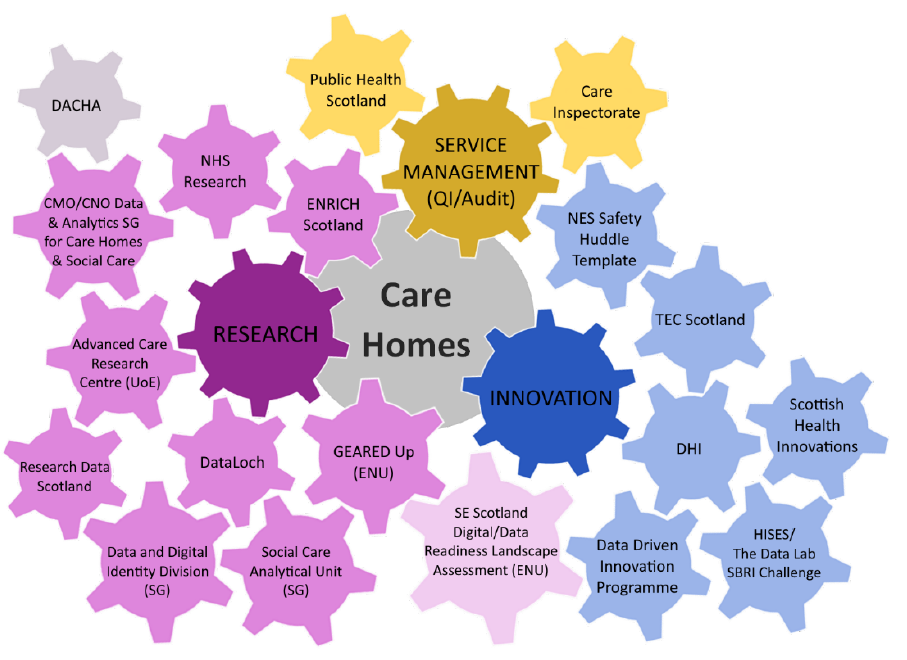
Figure 1. Multiple stakeholders are ‘gearing up’. A complex mix of stakeholders, in addition to pro- viders, have an interest in care home